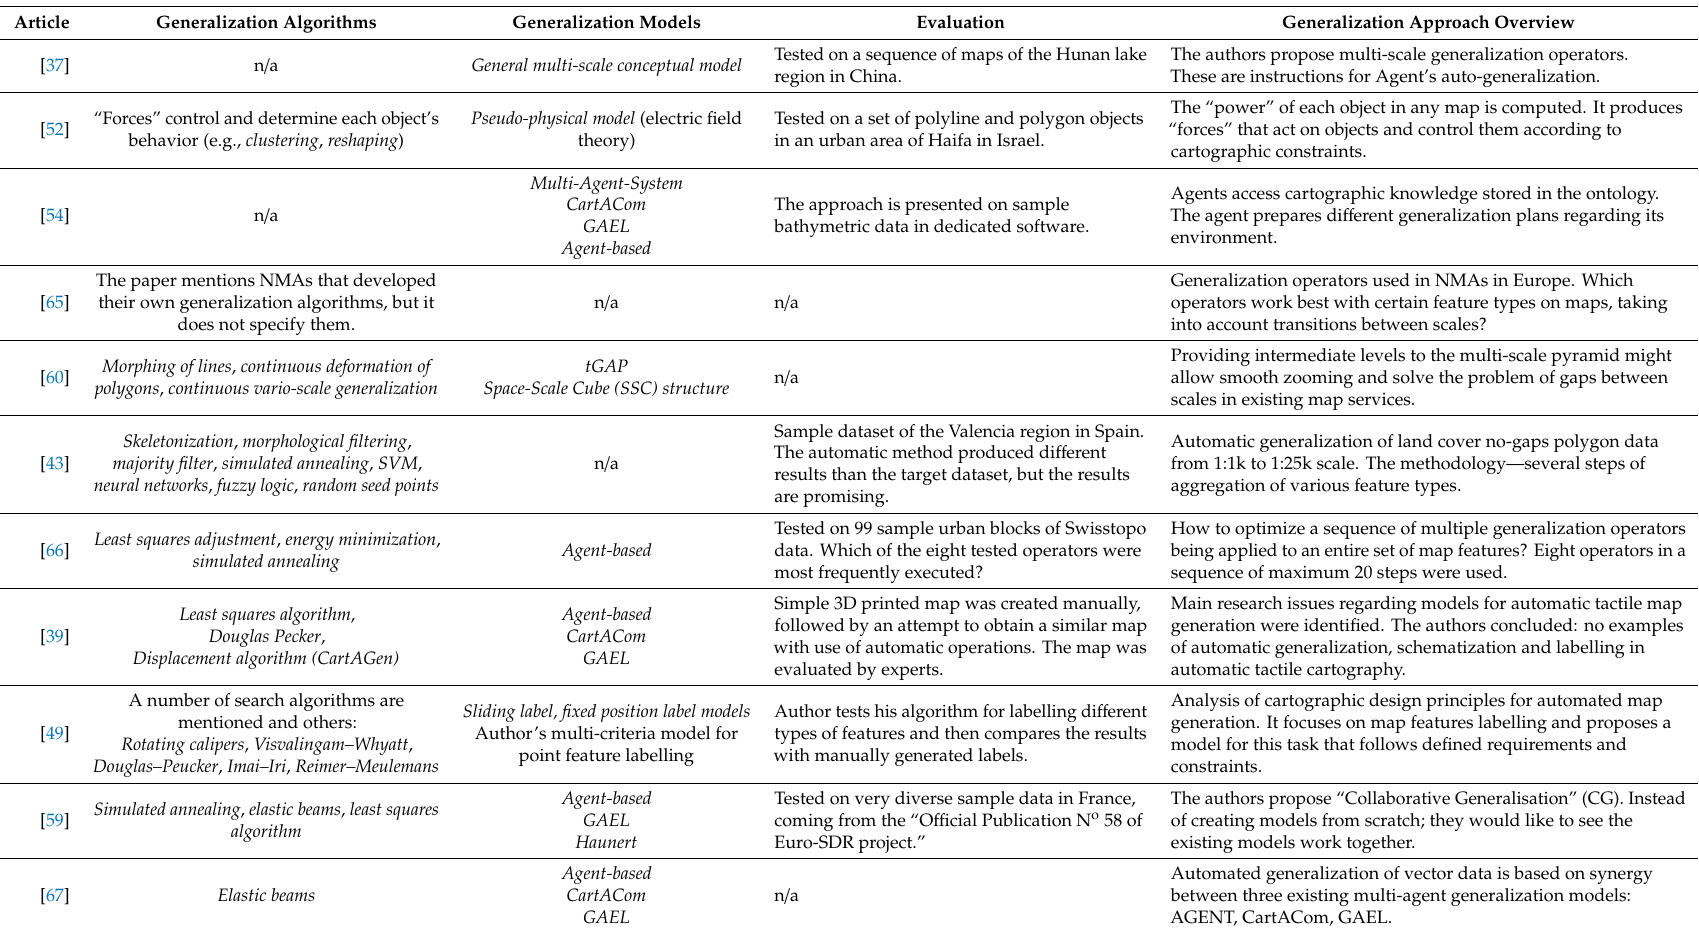
Table 2. Identified generalization algorithms and models (source: own